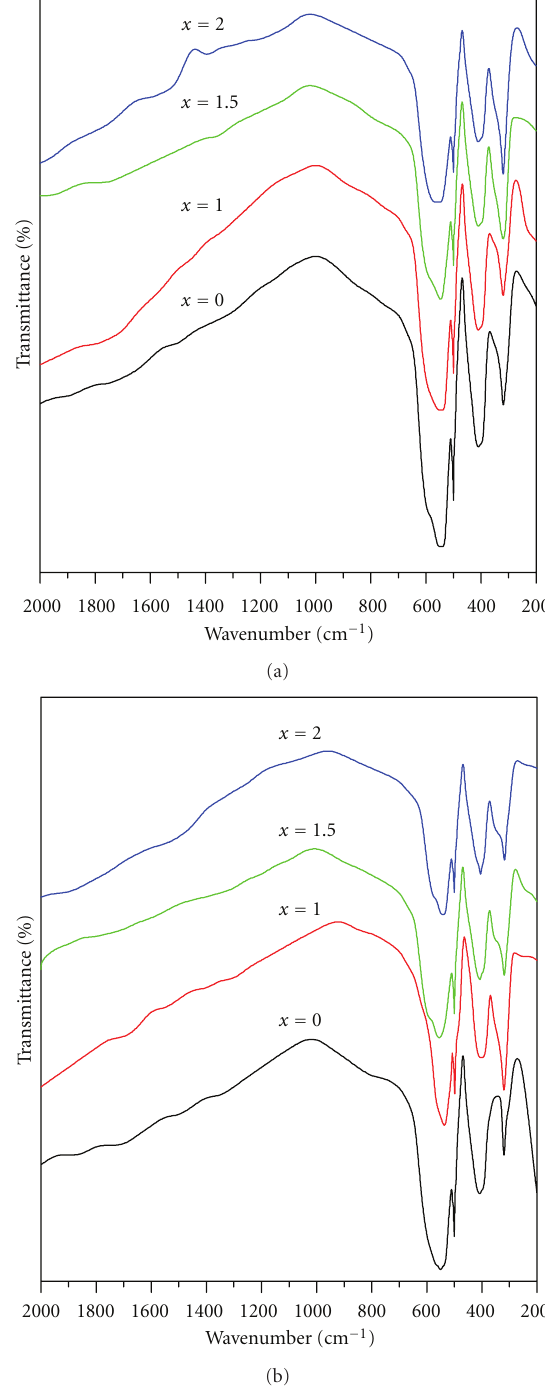
Figure 6: IR absorption spectra of BaTiO 3 -CuO + x wt% Ag samples sintered at (a) 500 ◦ C and (b) 700 ◦